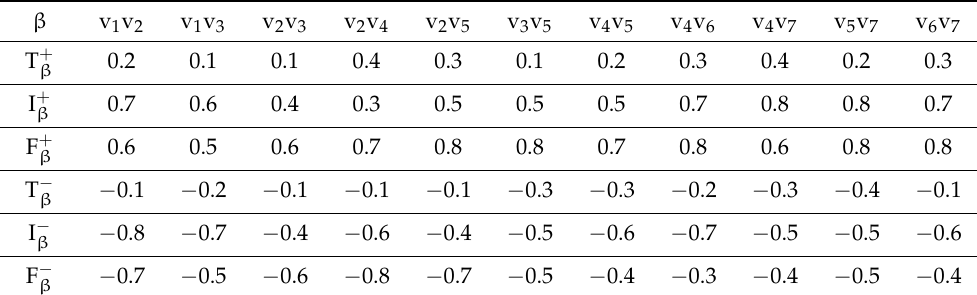
Table 7. Signless Laplacian energy of BSVNG relation on